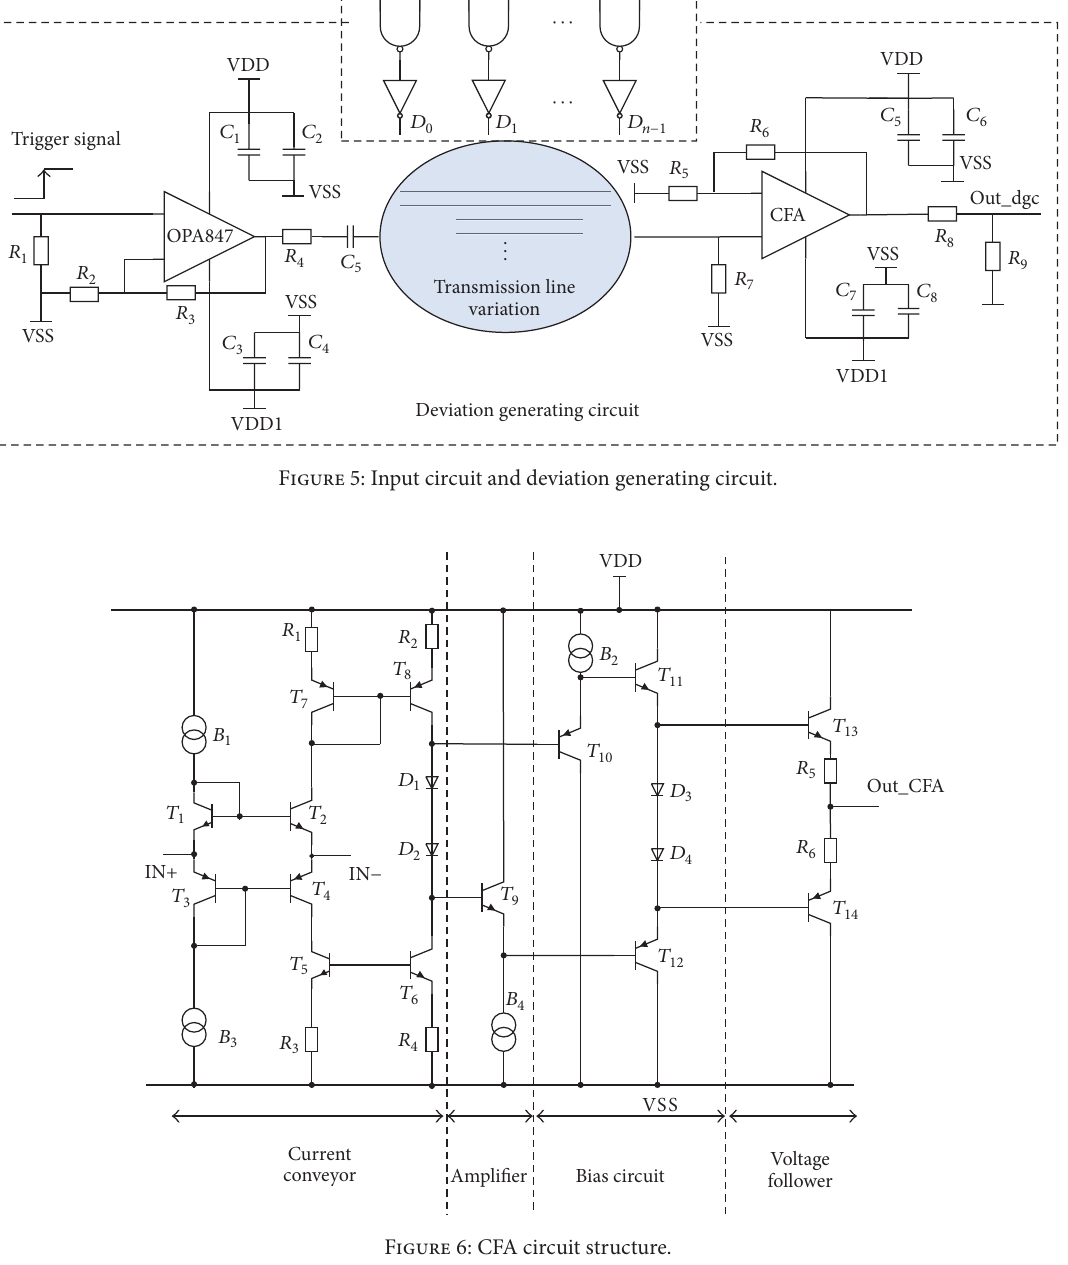
Figure 5. The input circuit is composed of 𝐷 flip-flops (DFF), NAND gates, and inverters, while the deviation generation circuit is composed of an operational amplifier (OPA847), transmission lines, and current feedback amplifier (CFA). The diagram of a current feedback amplifier is shown in Figure